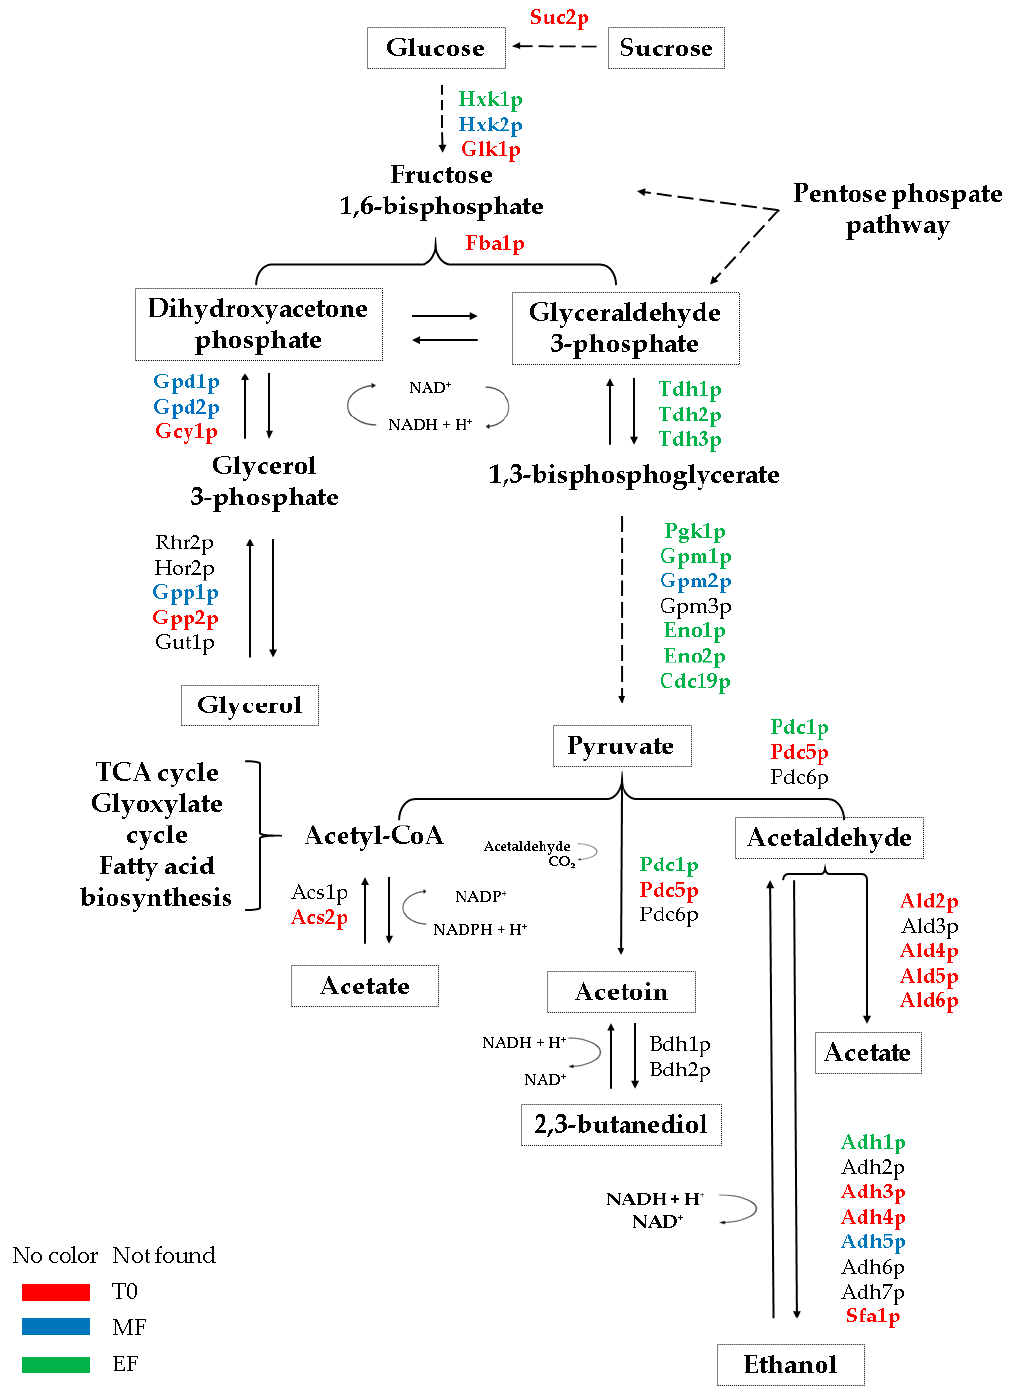
Figure 5. Summary of the scheme of proteins involved in the compounds derived from fermentation in Saccharomyces cerevisiae conventional yeast during the second fermentation in the production of sparkling wine. The color of the protein names represents the condition in which the highest protein content of the proteins was identified. Each condition is represented by a color: red for the base wine, T0; blue for the middle of the fermentation, MF; green for the end of the second fermentation, EF.